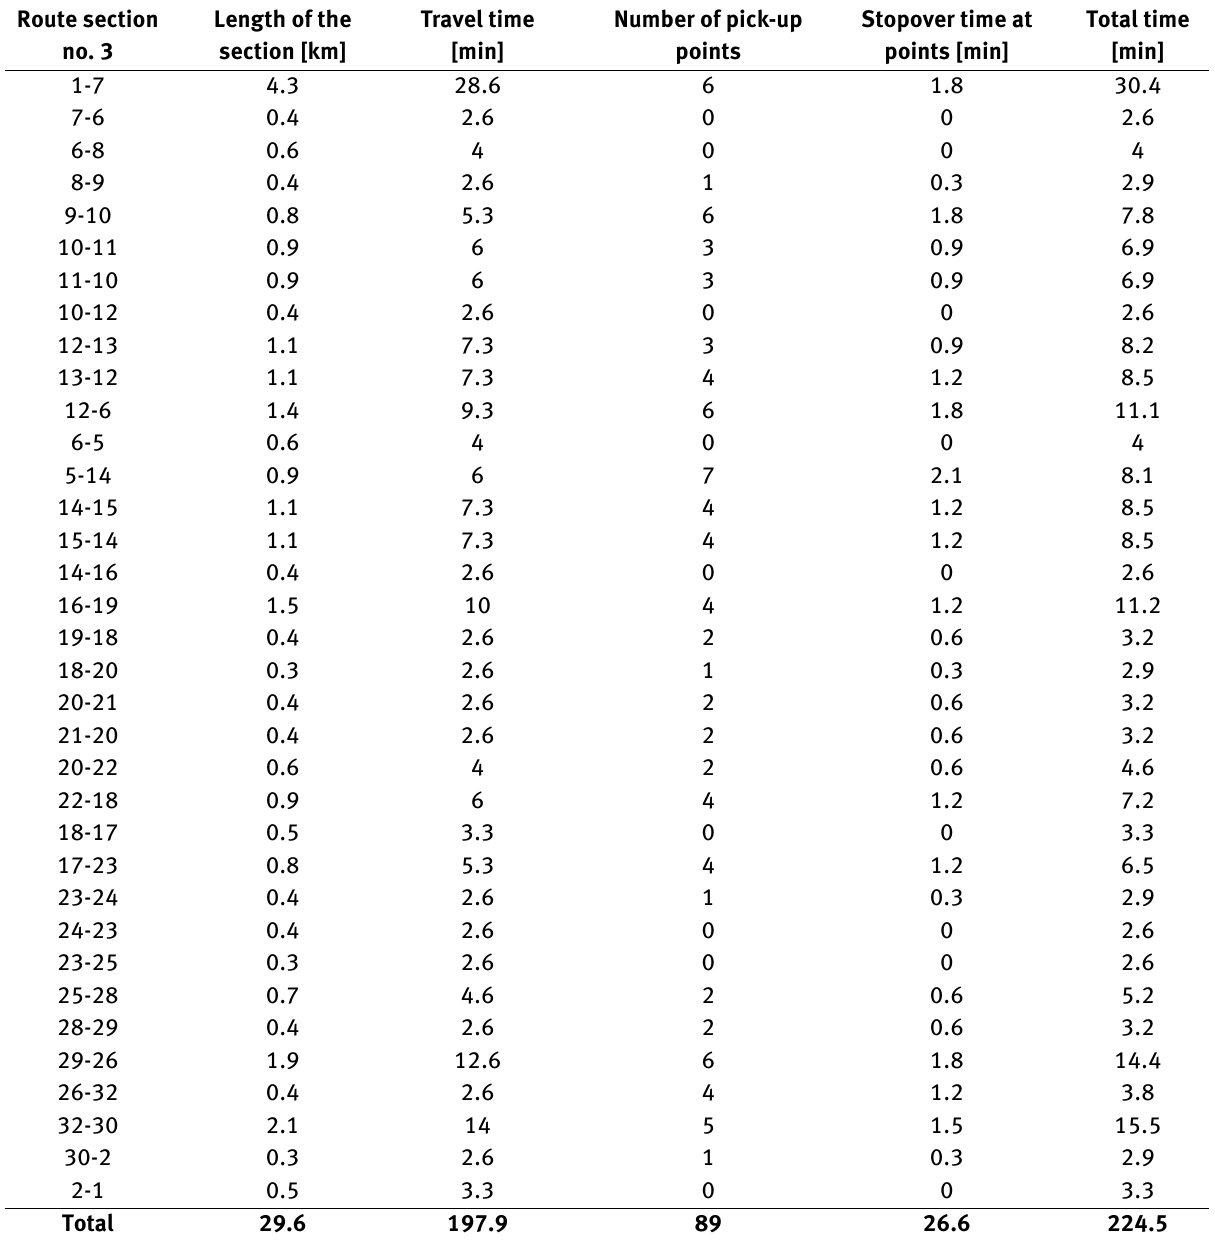
Table 7: Statement of the route of the waste collection after optimization by means of a decision model Route section